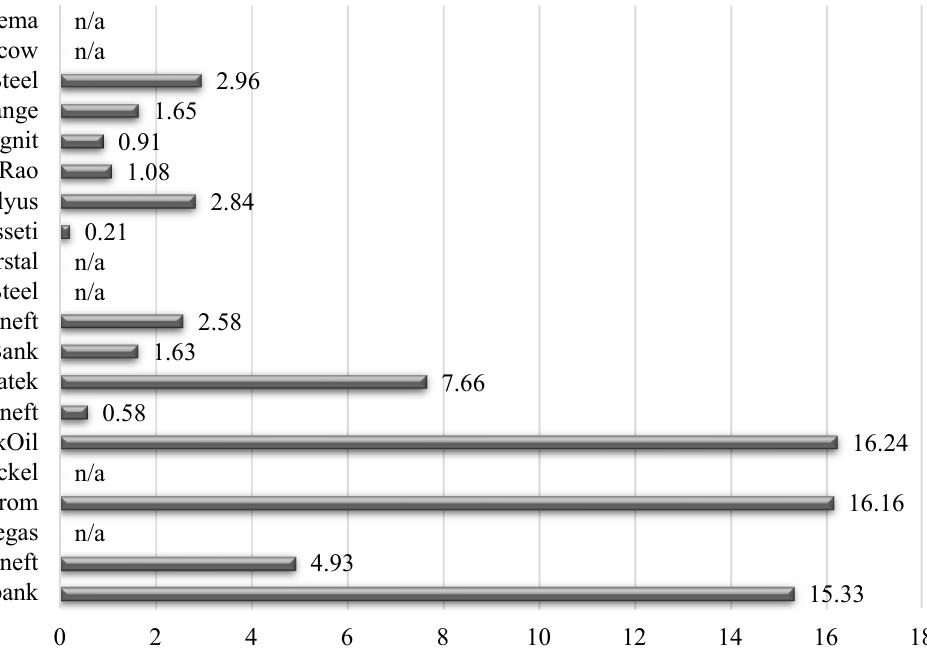
Figure 3. Responsibility and openness (weight in the MRRT index), %. Source: Formed, compared to the sample, and compiled by the authors based on Moscow Exchange (2021).